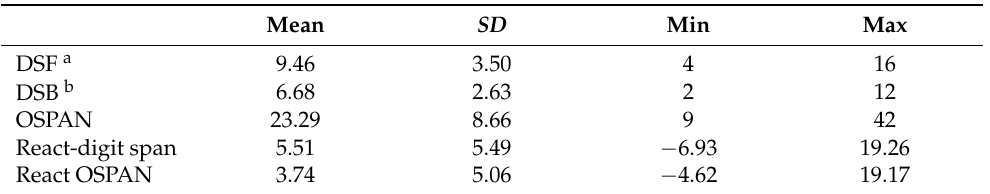
Table 1. Means, standard deviations ( SD ), and minimum (Min) and maximum (Max) values for the task performance variables and reactivity.